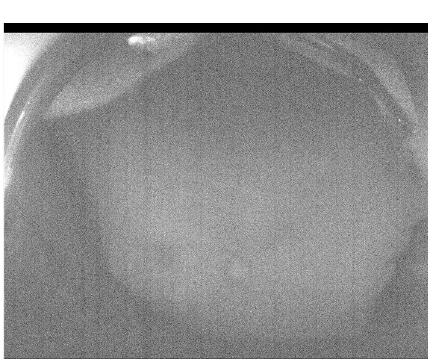
Figure 3. Fundus autofluorescence of case #4 (39 weeks of corrected gestational age), where low-grade hyper- autofluorescence contrasts with the hypo-autofluorescent structures that block the emission of light: optic nerve head, macular pigment, peripapillary vessels and vascular arcade. Note that vessels are not observed in the equatorial retina (approximate peak emission for fluorophores: λ610 nm; range for excitation maxima for the different fluorophores: λ430 nm – λ510 nm) 6 .